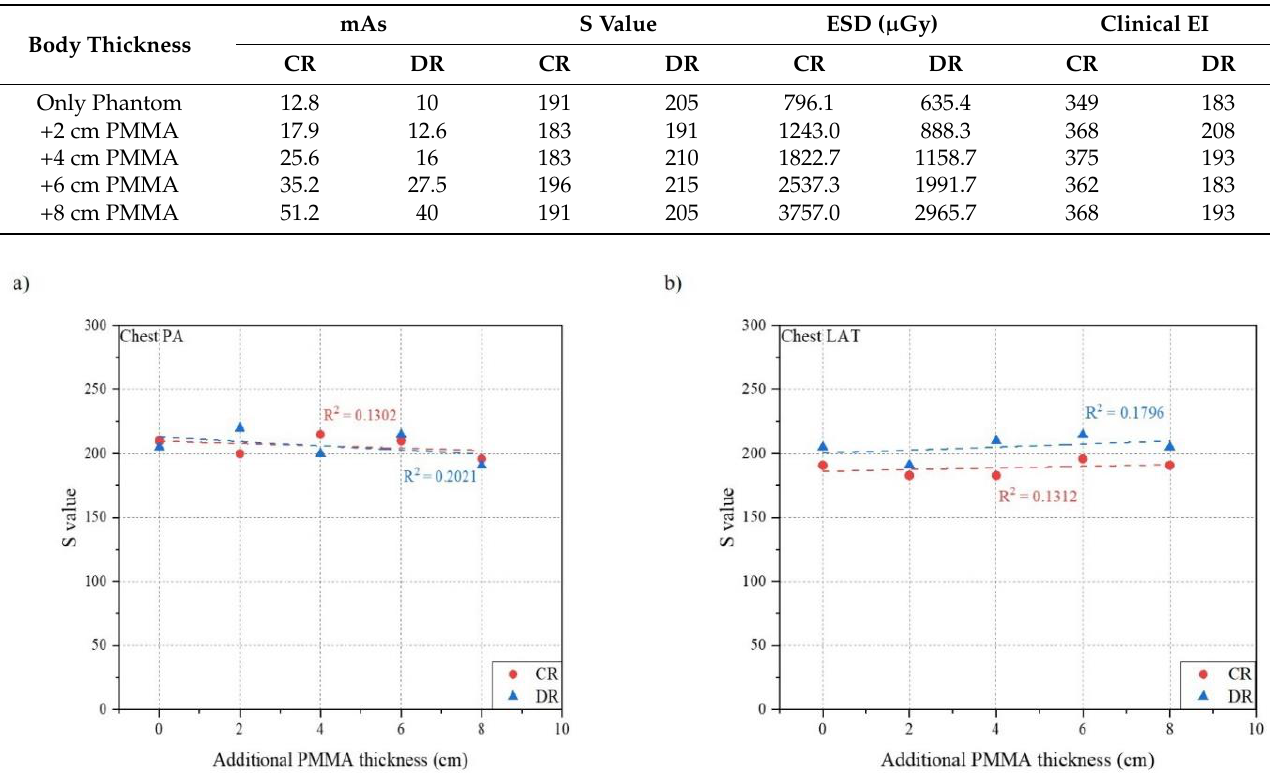
Figure 6. Relationship between phantom thickness and S value: ( a ) Chest PA; ( b ) Chest LAT.